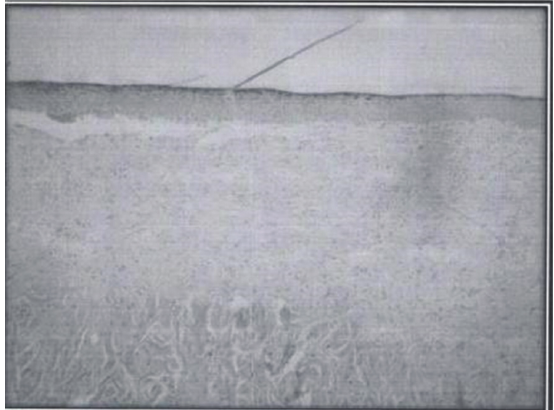
Fig 3.Histological image of test group dermis which shows normal epidermal cells, organized bundles of collagen and serous goblet cells